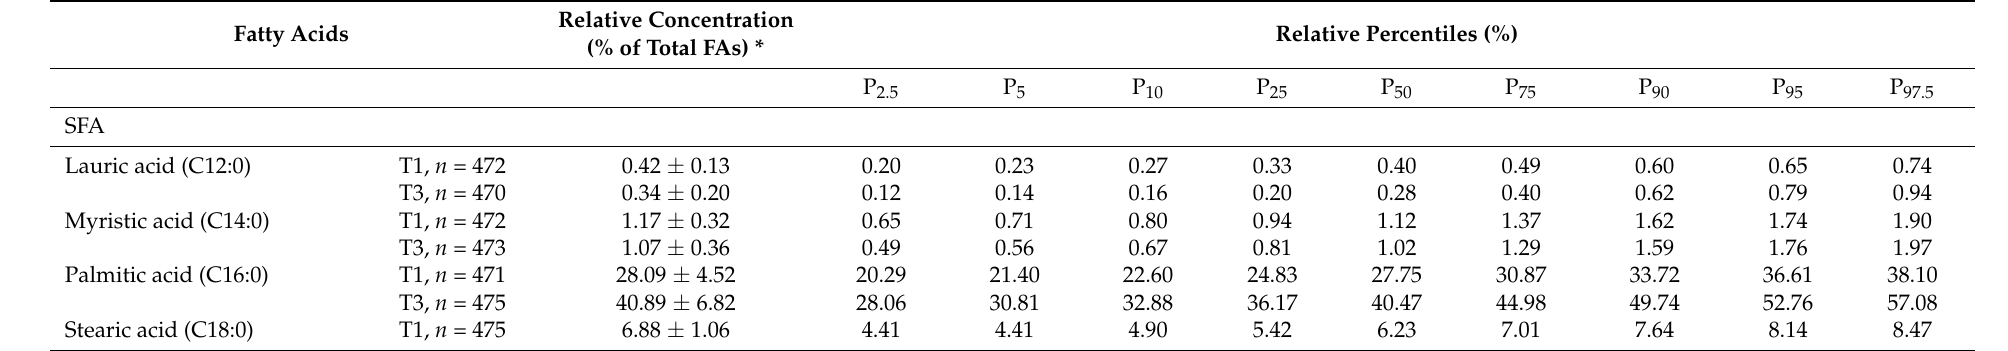
Table 3. Relative concentration and percentile (%) distribution of fatty acid in maternal serum during the first (T1) and third (T3) trimester of